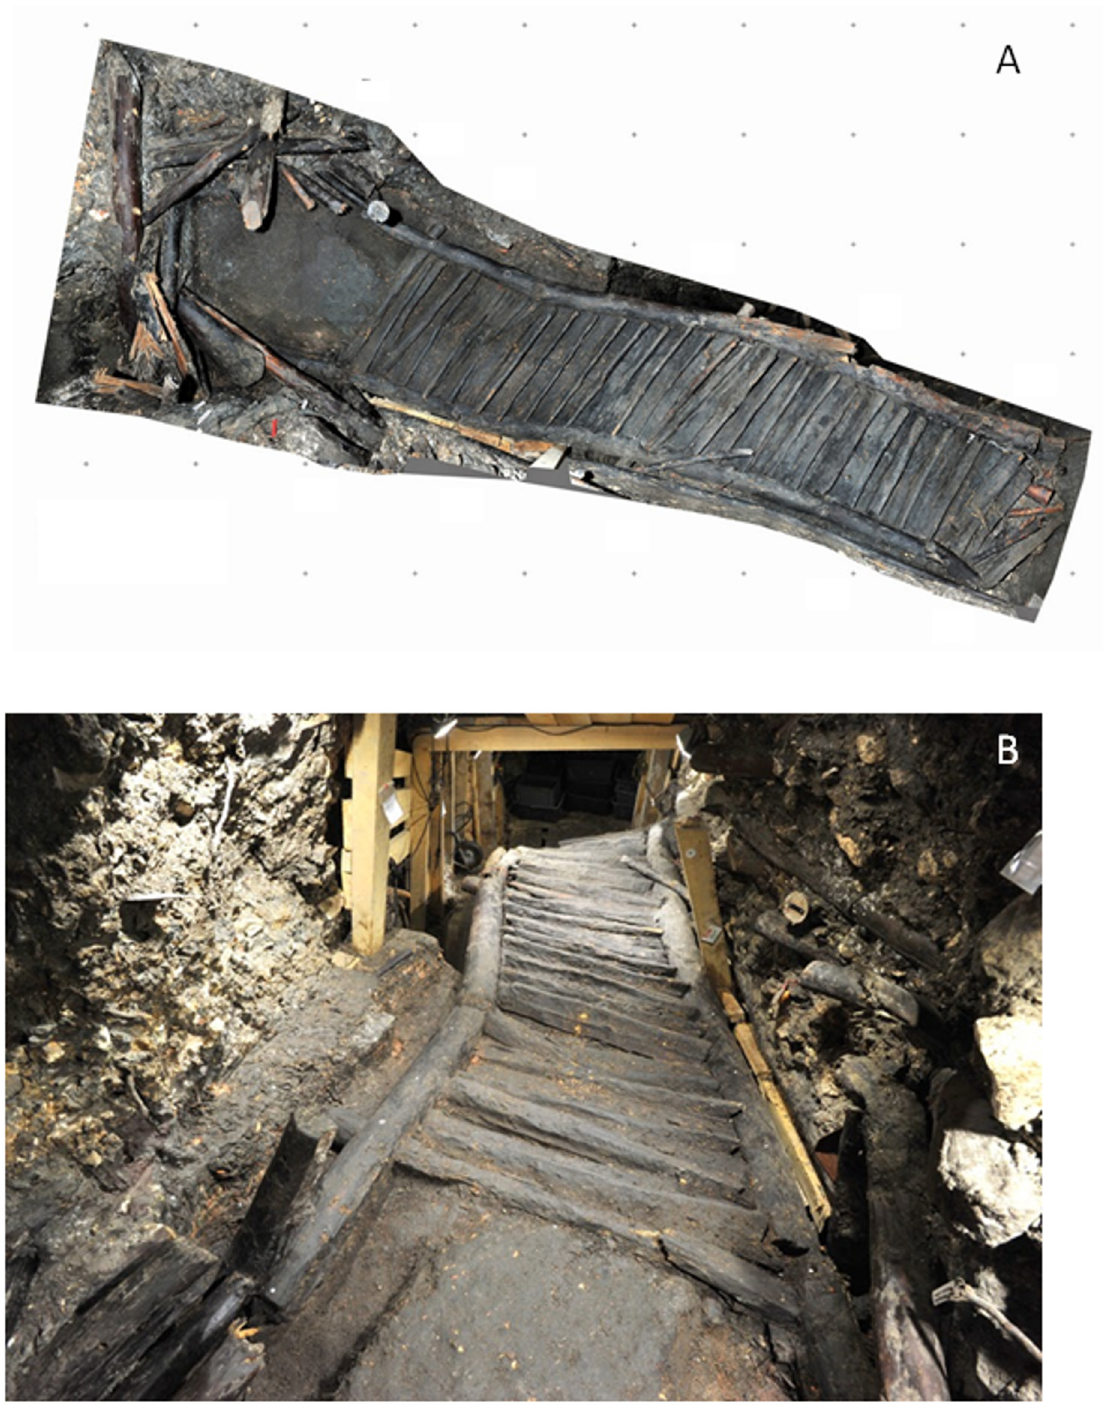
Fig 1. The staircase of Hallstatt. The 3100 years old staircase is 8 m long and 1.20 wide, and is representative of the construction typical of the Bronze Age (C: NHM/A. Rausch) ( A ). After its discovery, a wooden shelter was built over the staircase to ensure its preservation (C: NHM/A. Rausch) ( B ).